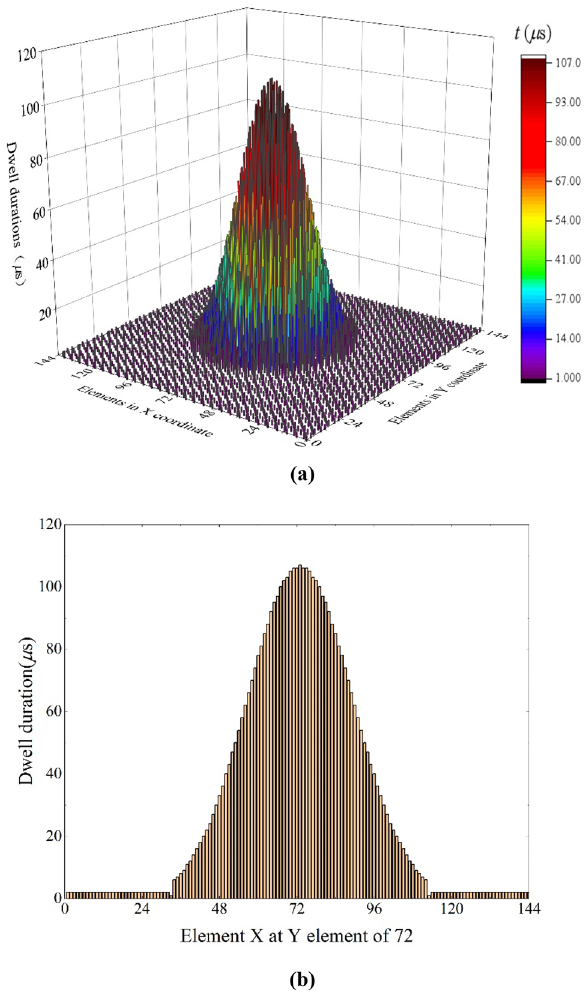
Figure 4. Dwell duration of the scanning strategy. ( a ) Results on the whole workpiece. ( b ) Results at Y element of